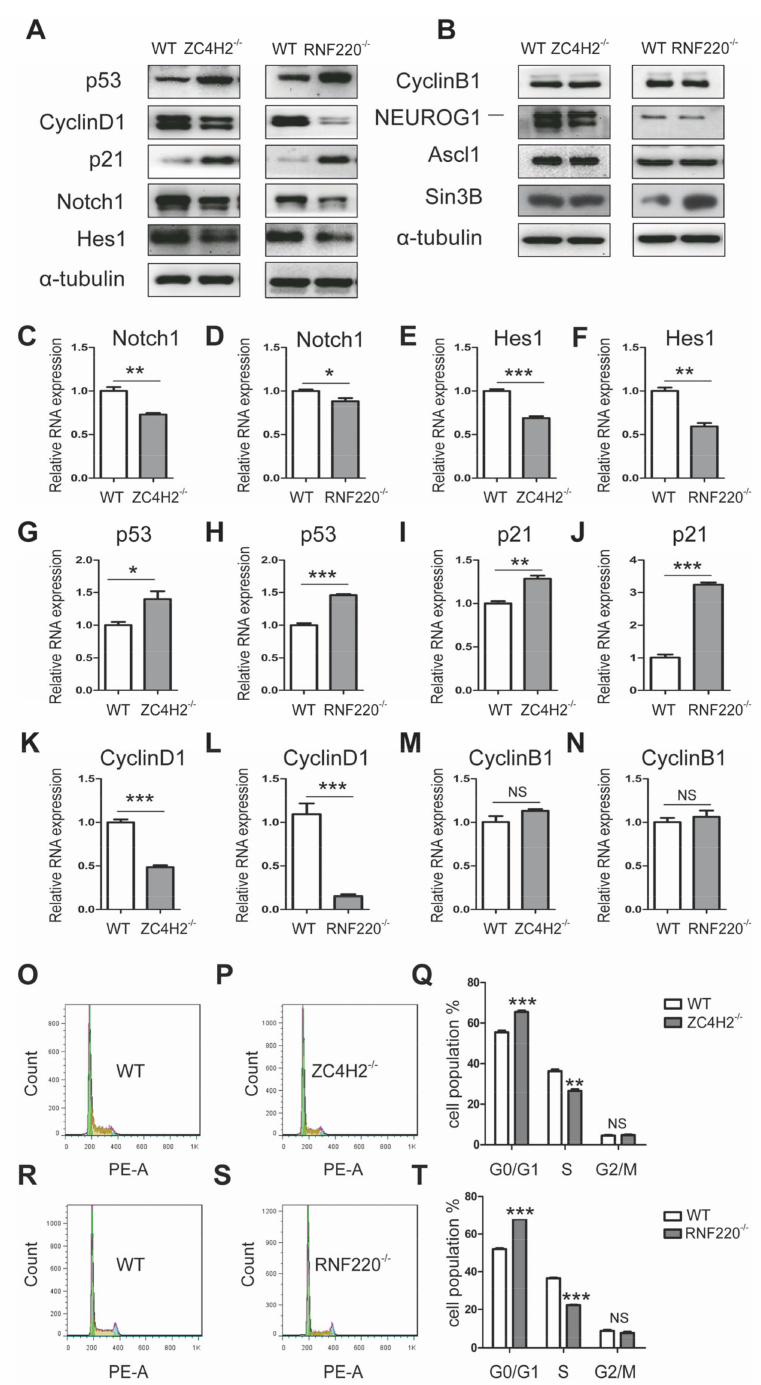
Figure 6. ZC4H2 / RNF220 regulate the Cend1 cascade during NSC proliferation. ( A , B ) Western blot analysis of the expression of potential Cend1-regulated proteins in WT, ZC4H2 − / − , and RNF220 − / − NSCs; α -tubulin was used as an internal control. ( C – N ) qRT-PCR analysis showing Notch1, Hes1, p53, p21, CyclinD1, and CyclinB1 mRNA levels in WT, ZC4H2 − / − , and RNF220 − / − NSCs; β -actin was used as an internal control. ( O – Q ) Cell cycle analysis of the WT and ZC4H2 − / − NSCs by FACS. ( R – T ) Cell cycle analysis of the WT and RNF220 − / − NSCs by FACS. NS represents no significant di ff erence ( p > 0.05). * p < 0.05, ** p < 0.01, *** p < 0.001, two-tailed Student’s t -test. Data represent mean ± SD from three independent biological